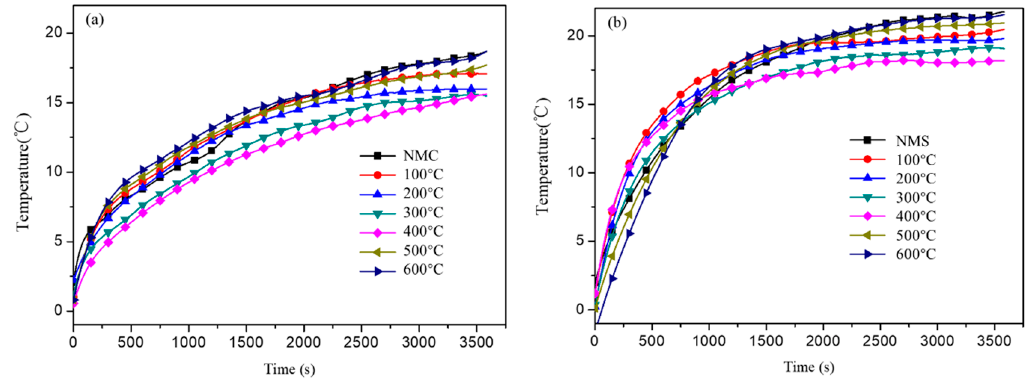
Figure 8. The external temperature rise of coatings with calcined shell powder ( a ) cement board, ( b ) steel plate. NMC and NMS represent coating with as-received shell powder.